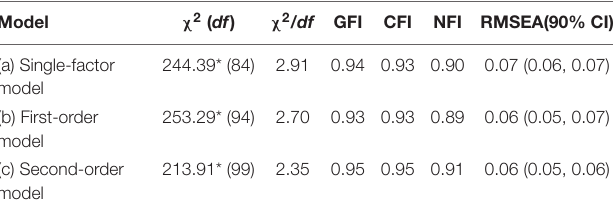
TABLE 7 | Study 3 – structural equation model analysis of the 16-item